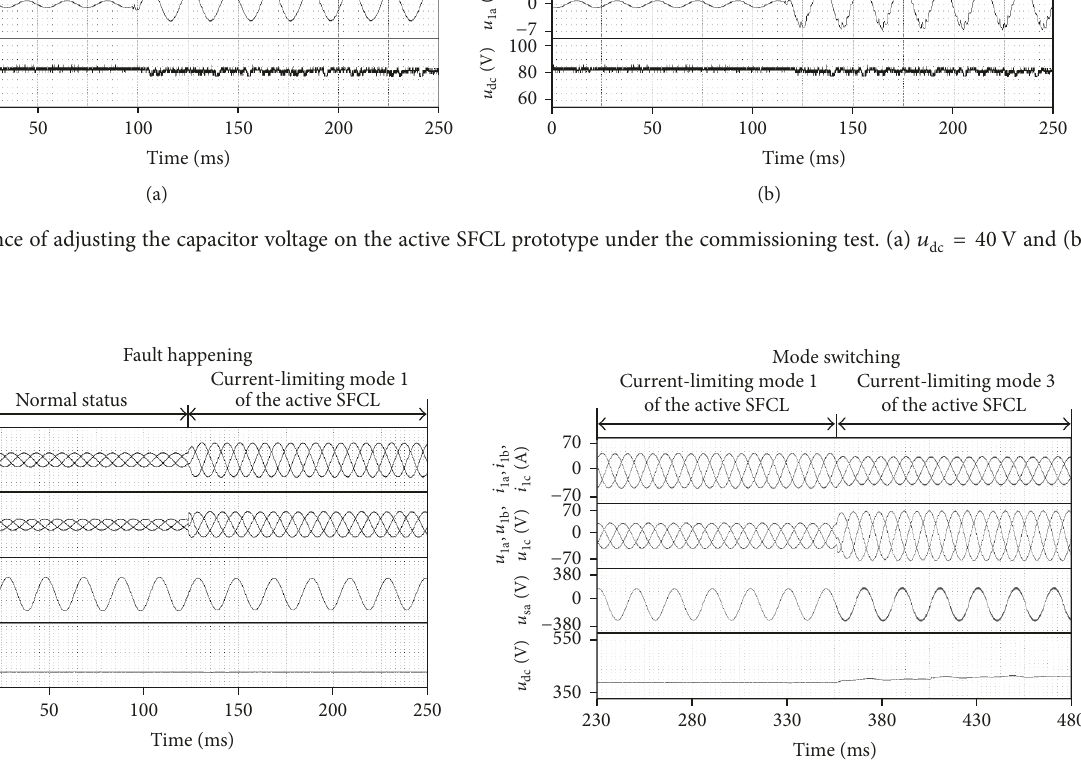
Figure10:PerformanceoftheactiveSFCLprototypecorresponding to mode 1 under the current-limiting test.